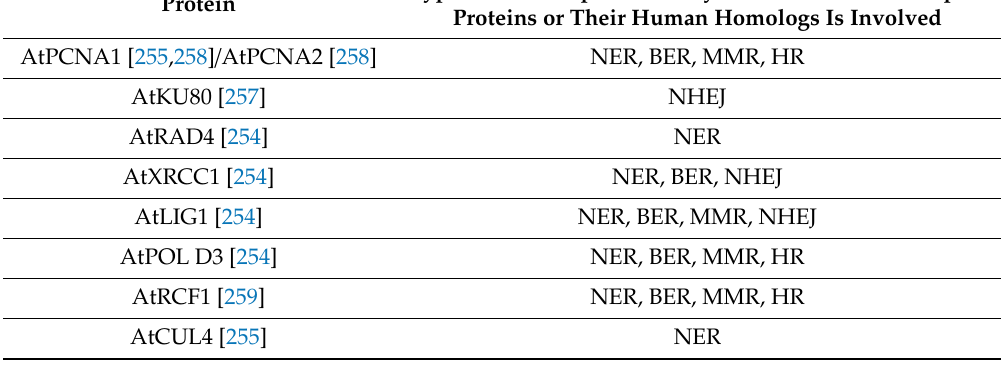
Table 1. List of Selected Arabidopsis Proteins whose Role is Attributed to the Dark Repair of UV-Induced DNA Damage whose Sumoylation was Confirmed Experimentally. Type of DNA Repair Pathway in Which the Arabidopsis Protein Proteins or Their Human Homologs Is